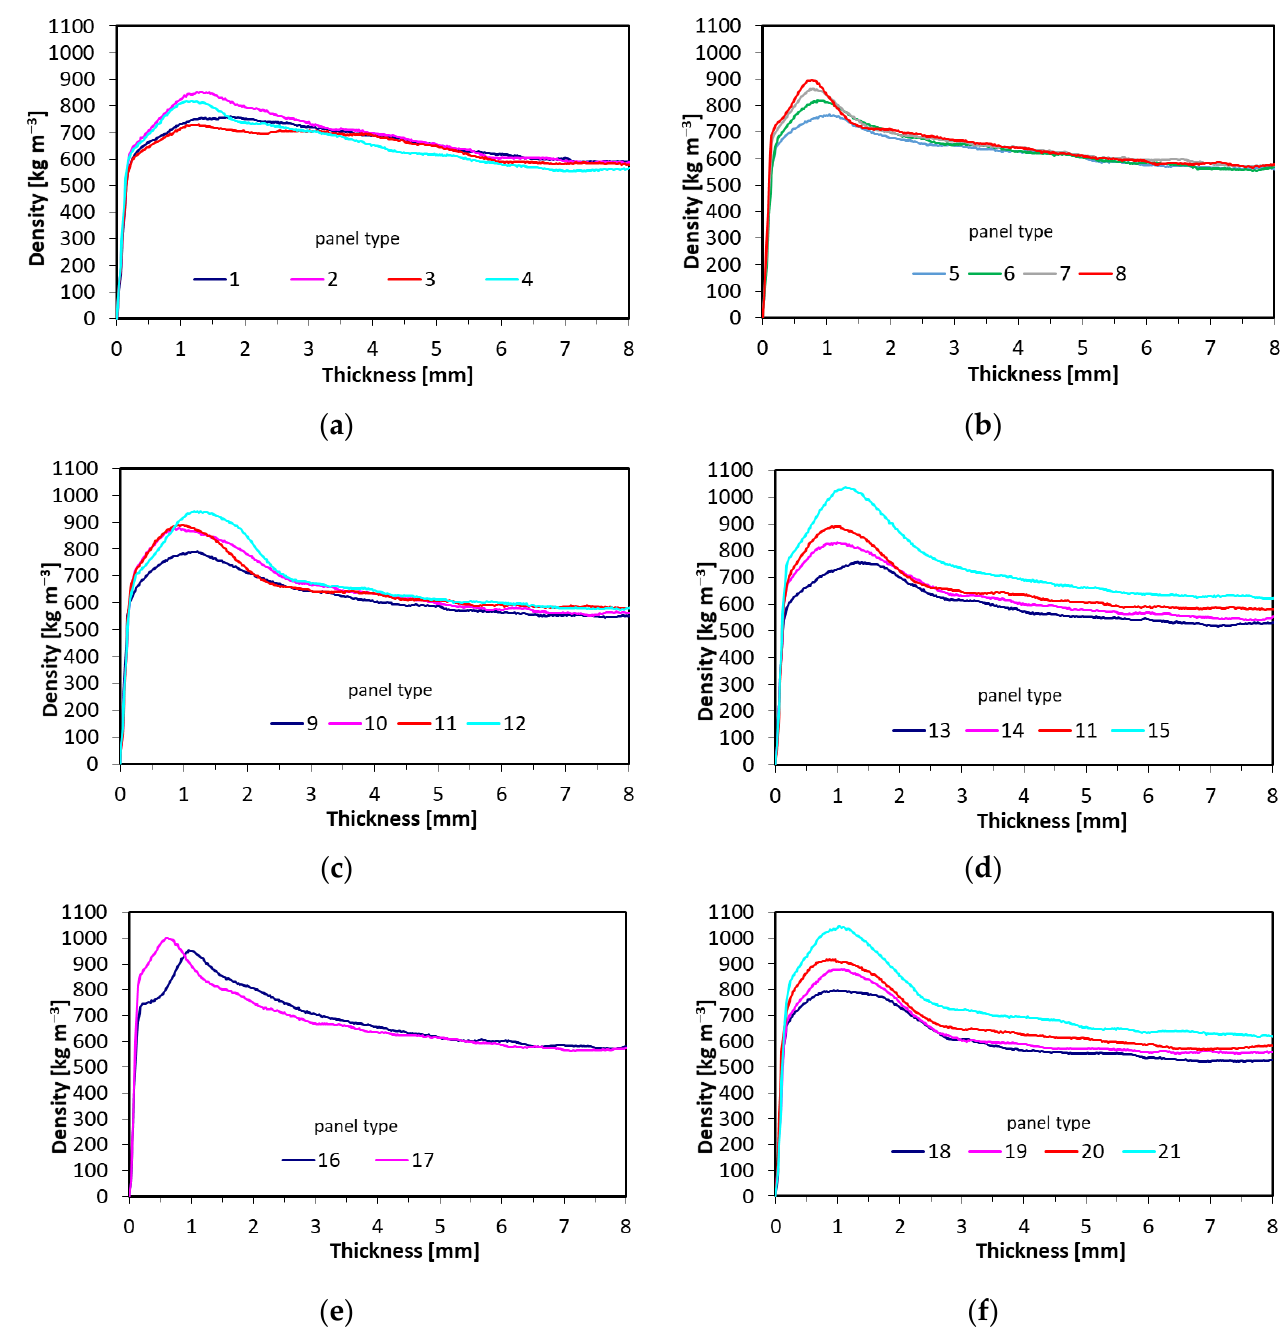
Figure 9. Density profiles of tested panels: ( a ) single layer, various share of fibers, ( b ) 3-layer panels, 16% face layers’ share, ( c ) 3-layer panels, 32% face layers’ share, ( d ) 50% fibers’ type 1. share, various densities, ( e ) different type of fibers when blended with glue separately, fibers and particles, ( f ) 50% fibers’ type 2. share, various density.